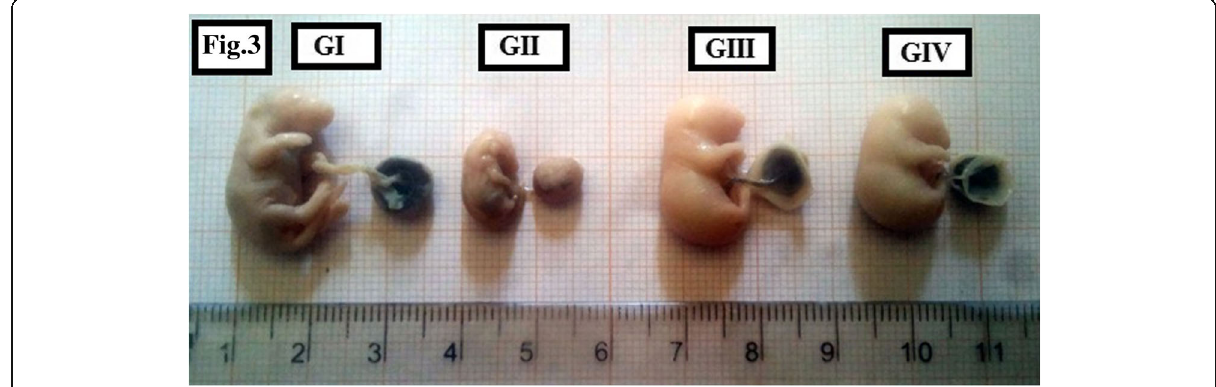
Fig. 3 Photomicrograph of 18-day-old fetuses of different groups showing the effect of diabetes and/or olive leaves extract on fetus/placental